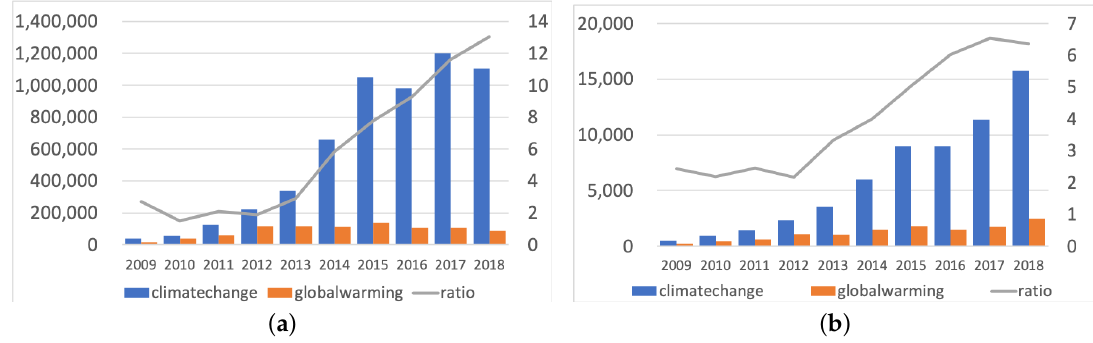
Figure 1. The number of tweets containing #climatechange or #globalwarming, and their ratio from 2009 to 2018 ( a ). The number of hashtags contained in the “climate change” or “global warming” datasets, and their ratio from 2009 to 2018 ( b ).